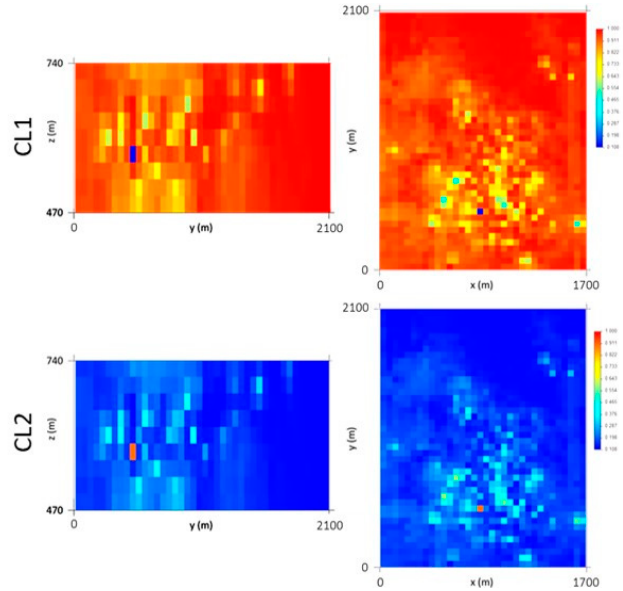
Figure 11. Indicator Kriging results for the CL1 and CL2 class groupings: Px81 (left) and Pz75 (right). 3.4.3. DSS of Wolframite Quantity Conditioned to CL1 and CL2 Histograms Using the 10 m × 10 m × 2 m Grid